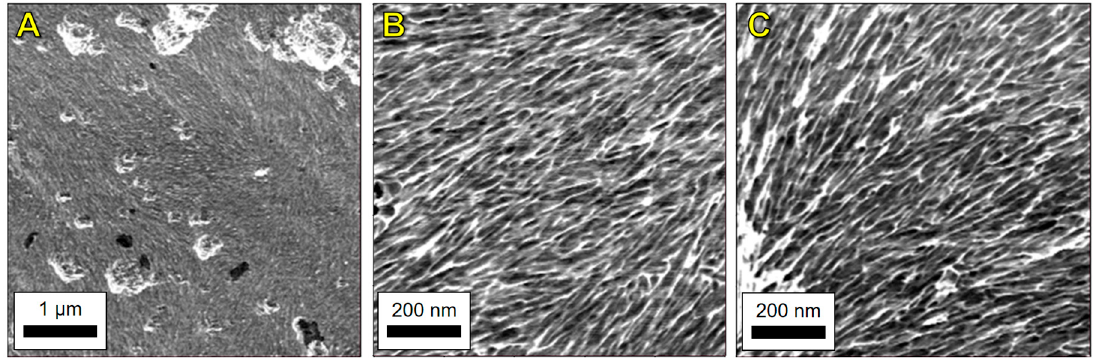
Figure A5. AFM phase retrace images of ( A ) 0.5 mg TOCN at 5 µm scan size, ( B ) 0.5 mg TOCN at 1 µm scan size, and ( C ) 0.75 mg TOCN at 1 µm scan size. These phase images correspond with